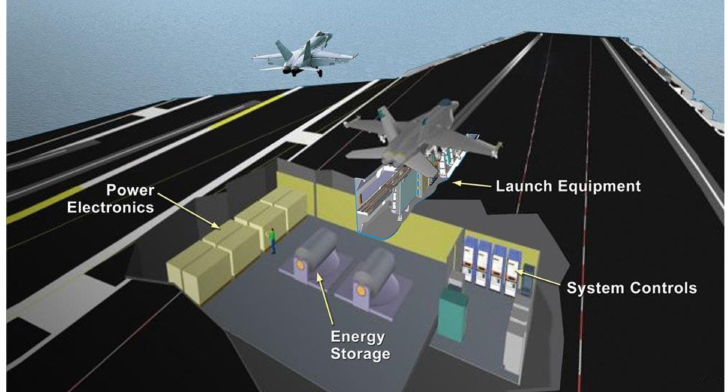
Figure 20. Electromagnetic aircraft launch system, adapted from